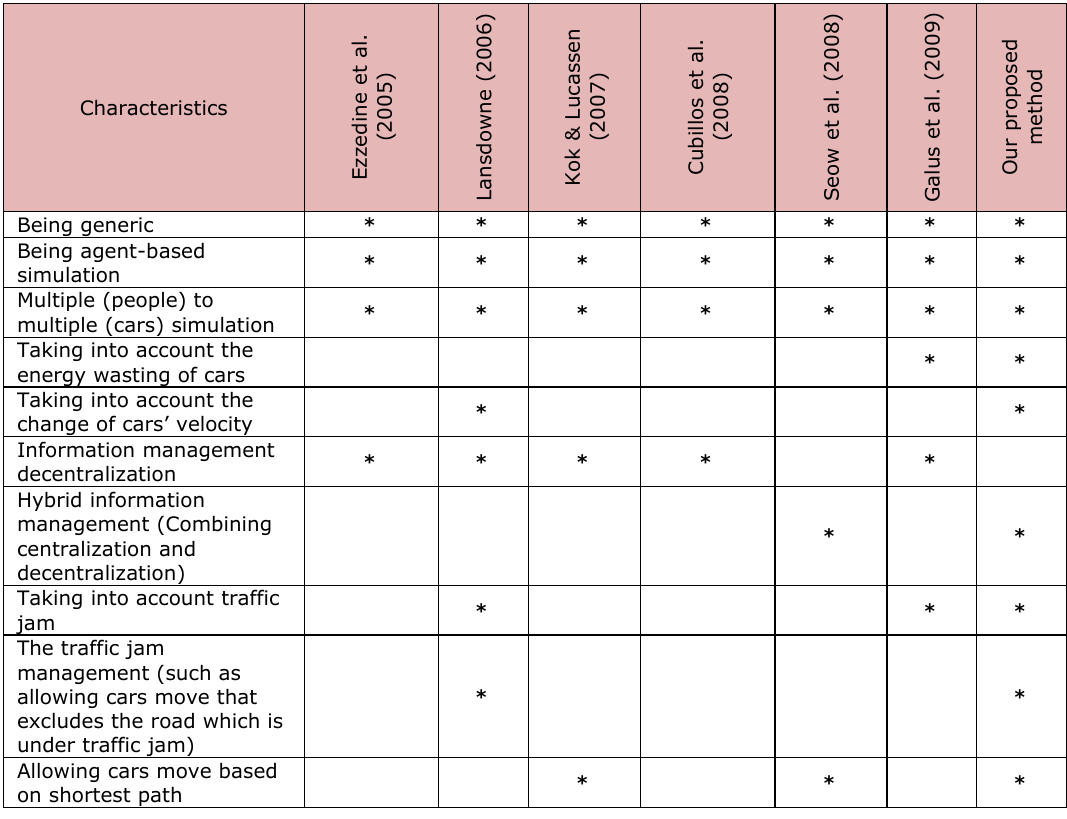
Table 1. “Criteria distinguishing our method from those existing in literature